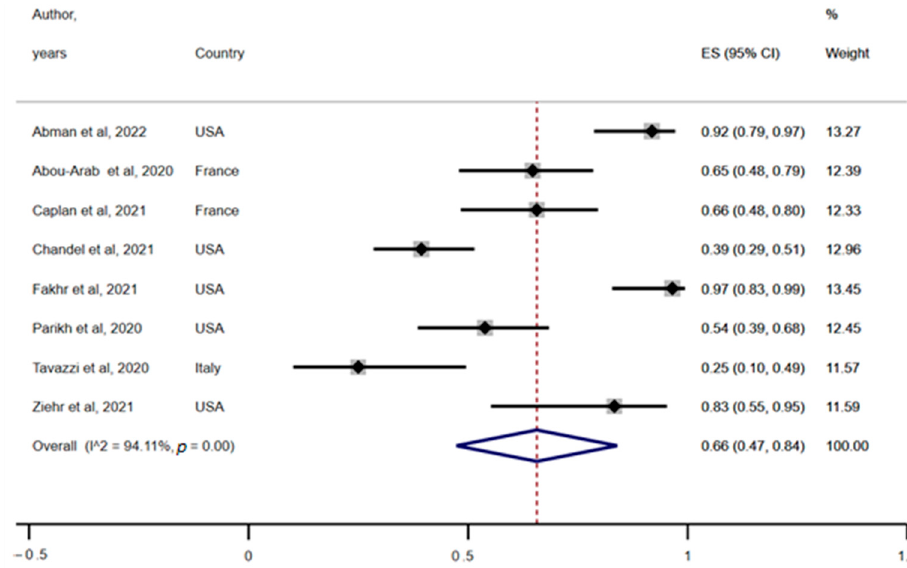
Figure 2. Pooled prevalence of rate of response to inhaled nitric oxide (iNO) in patients with COVID-19. Red dotted line represents overall response rate (0.66). Lateral edges of blue diamond represent extreme or limits of the 95% confidence interval (95% CI: 0.47, 0.84). ES = effect size; USA = United States of America.